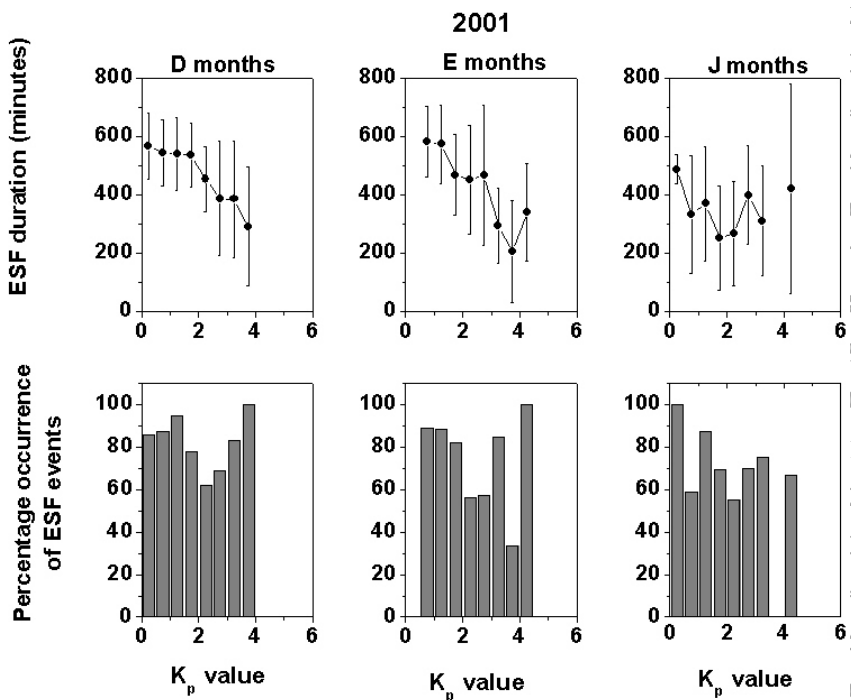
Fig. 4a. Distribution of the percentage occurrence of ESF events (bottom panel) and the average ESF duration with the standard deviation (top panel) against the magnetic activity index K p for the different seasons during the solar maximum year of 2001. K p values are taken in intervals of 0.5.